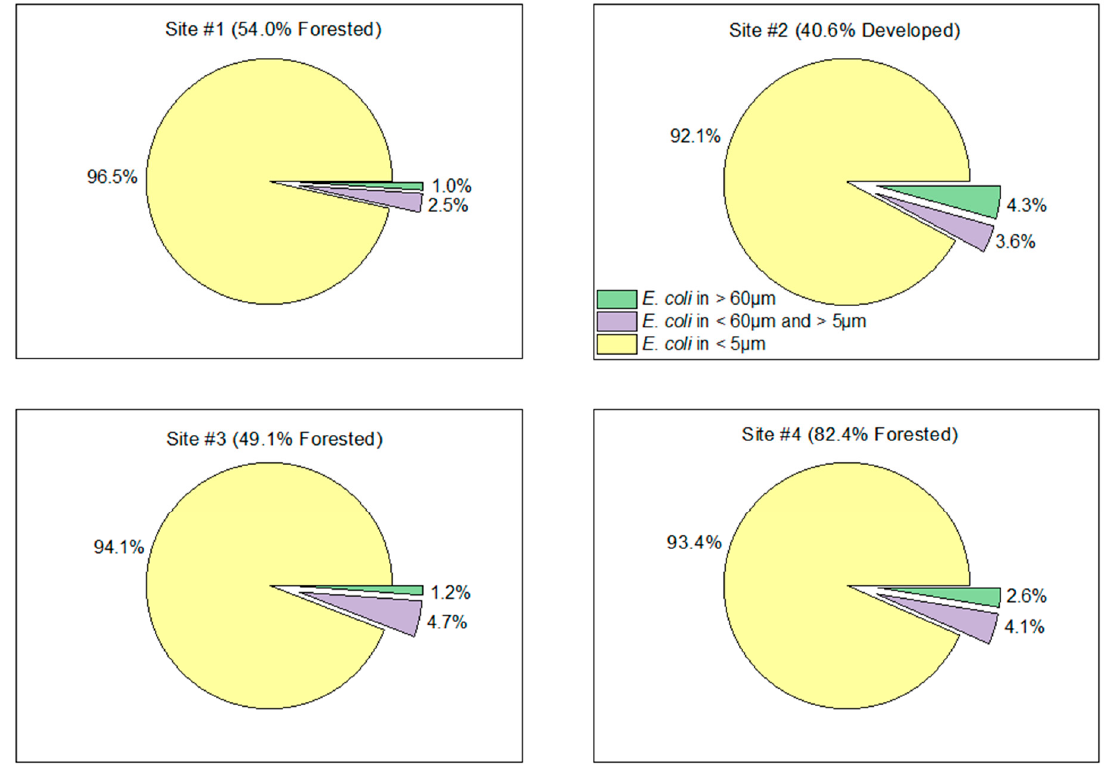
Figure 5. Fractions of E. coli concentration (CFU) in three filtered size intervals, at four monitoring sites during the study period (20 July 2018–27 October 2018) in West Run Watershed, Morgantown, West Virginia, USA.